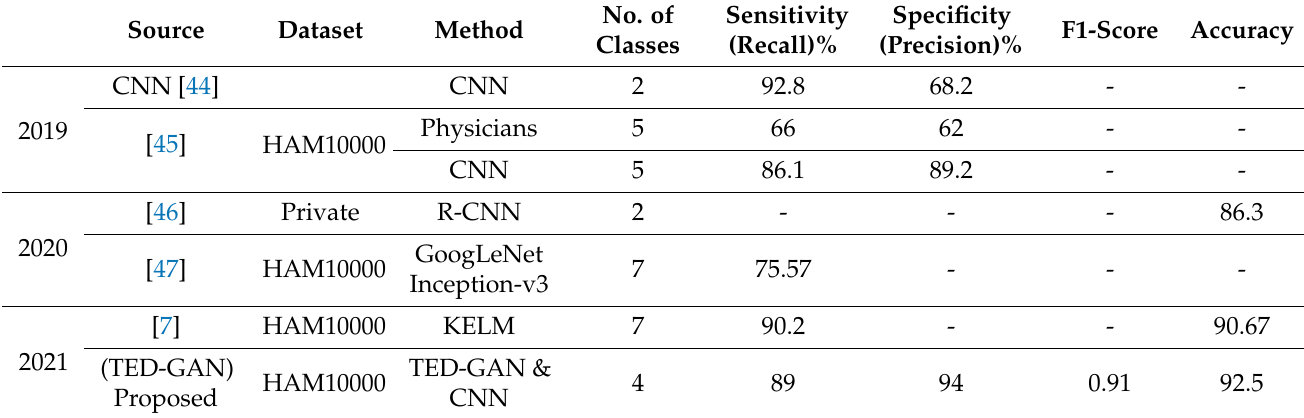
Table 2. Comparison of proposed TED-GAN classification results with various studies published within the last three years.